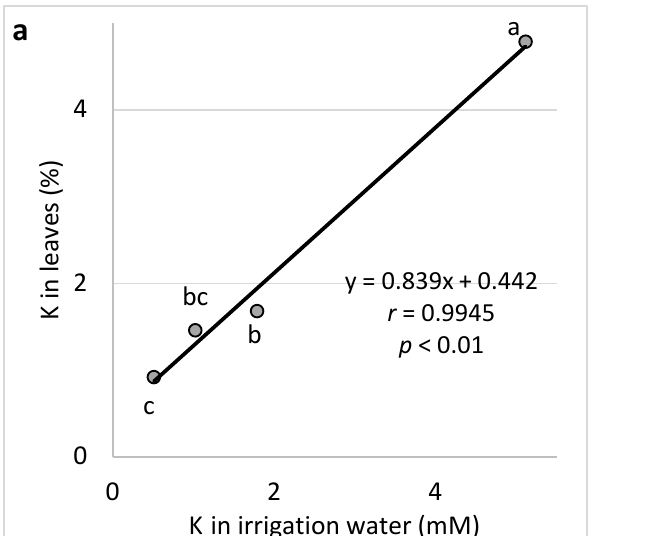
Figure 3. Effect of K concentration treatments in the irrigation water on cucumber downy mildew (CDM, Pseudoperonospora cubensis ). K concentration in the leaves is presented in relation to K con- centration in the irrigation water ( a ), CDM severity is presented in relation to K concentration in the irrigation water ( b ), and CDM severity is presented in relation to the K concentration in the leaves ( c ). The disease was evaluated on a 0 to 100% severity scale, where 0% = healthy leaves and 100% = leaves completely covered by CDM symptoms. Values of the area under the disease progress curve (AUDPC) were calculated for 18 days after disease onset. In each graph, values for each K treatment followed by a common letter are significantly not different from each other according to Tukey- Kramer’s HSD test ( p ≤ 0.05). The regression formula s of the drawn trend lines are presented, and the correlation Pearson regression values ( r ) are presented along with significance levels ( p ). 2.1.2. Relationship between Ca and Mg Nutrition through the Fertigation Solution with CDM Severity The effect of Ca and Mg on CDM severity was tested by adding their Cl − salts to the irrigation water without changing the concentrations of the other major ions (see Section 4). Ca ( Expts B-Ca-f ): Increasing the concentration of Ca in the fertigation solution from 1.0 to 4.0 mM resulted in a gradual increase in Ca concentration in the cucumber leaves up to 4.17% of the leaf dry weight (Figure 4a). An increase in the Ca concentration in the